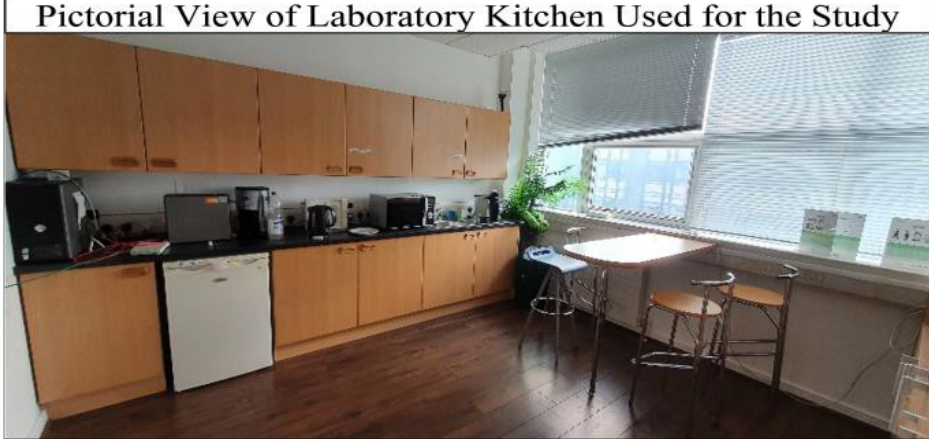
Figure 1. Pictorial view of the smart laboratory kitchen used for the study. A detailed description of the kitchen layout is presented in Figure 2 .